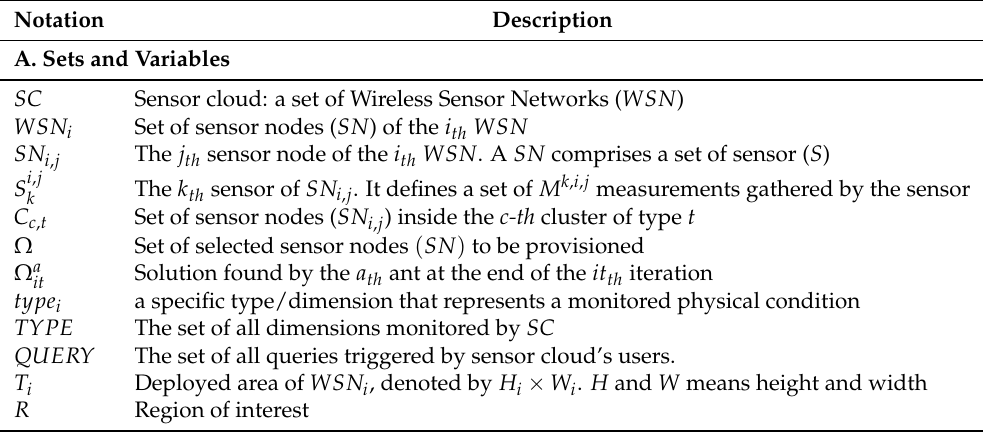
Table 1. Notations used in the